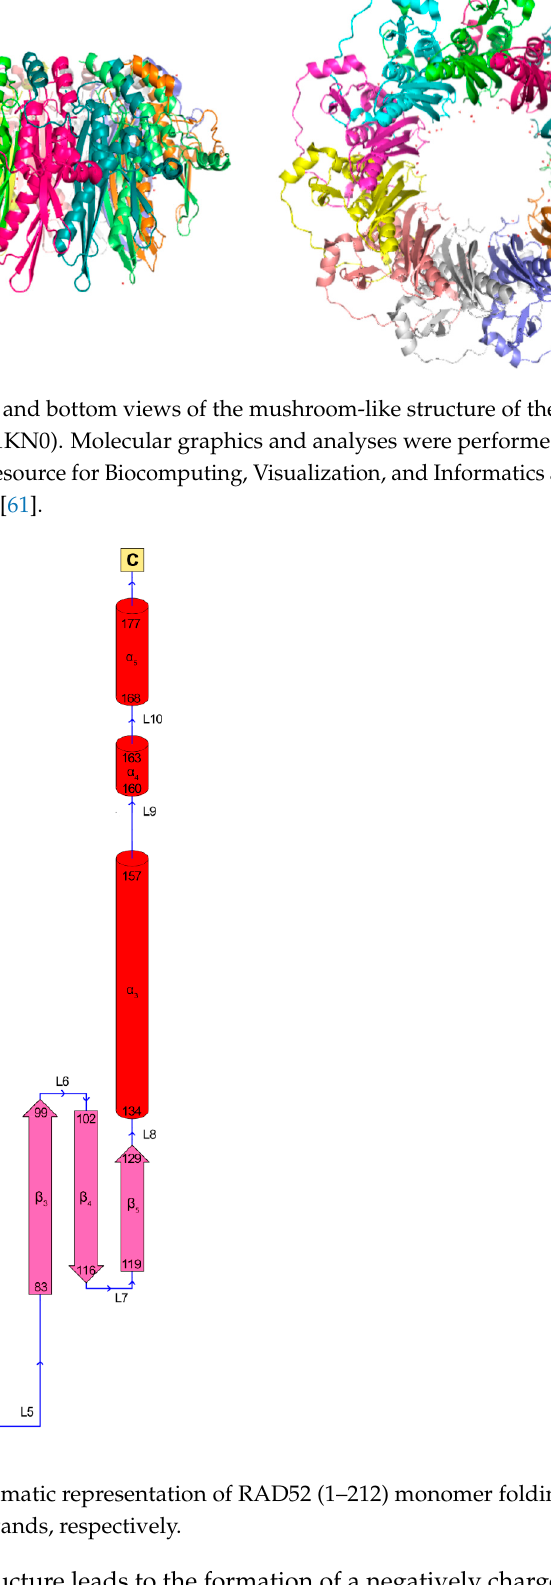
Figure 7. Schematic representation of RAD52 (1–212) monomer surface electrostatic potentials (PDB 1KN0). The representation was carried out using the Coulombic tool of UCSF Chimera, where − 10 was set as the minimum (red) and 10 was set as the maximum (blue).